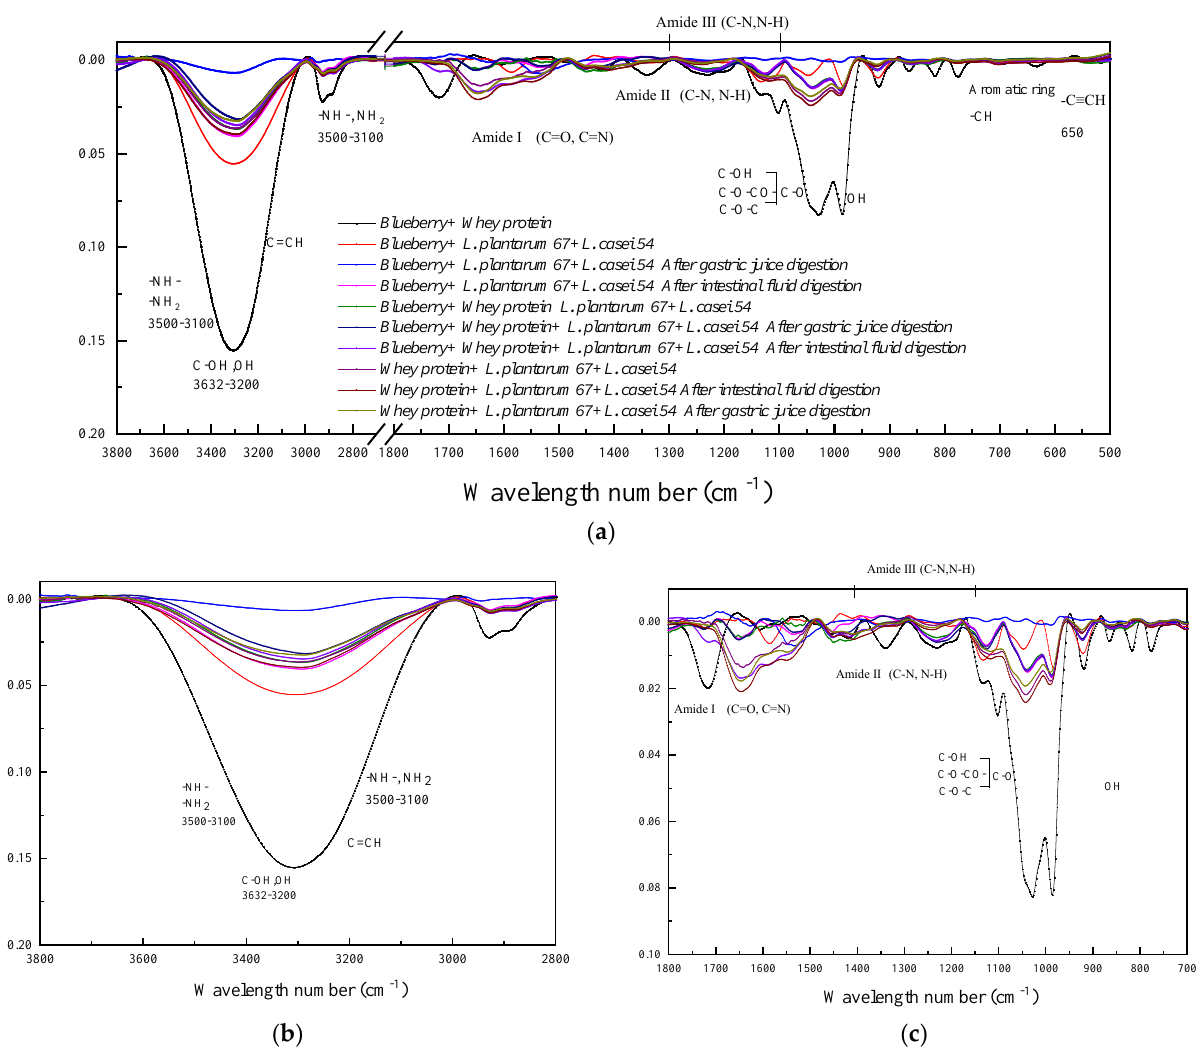
Figure 4. FTIR spectrum analysis at 3800–500 cm − 1 ( a ), spectrum analysis at 3800–2800 cm − 1 ( b ), and spectrum analysis at 1800–700 cm − 1 ( c ), of blueberry juice and whey protein fermentation system in vitro gastrointestinal digestion.